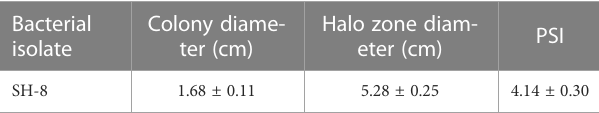
TABLE 2 Phosphate solubilization index (PSI) of the novel bacterial isolate SH-8.